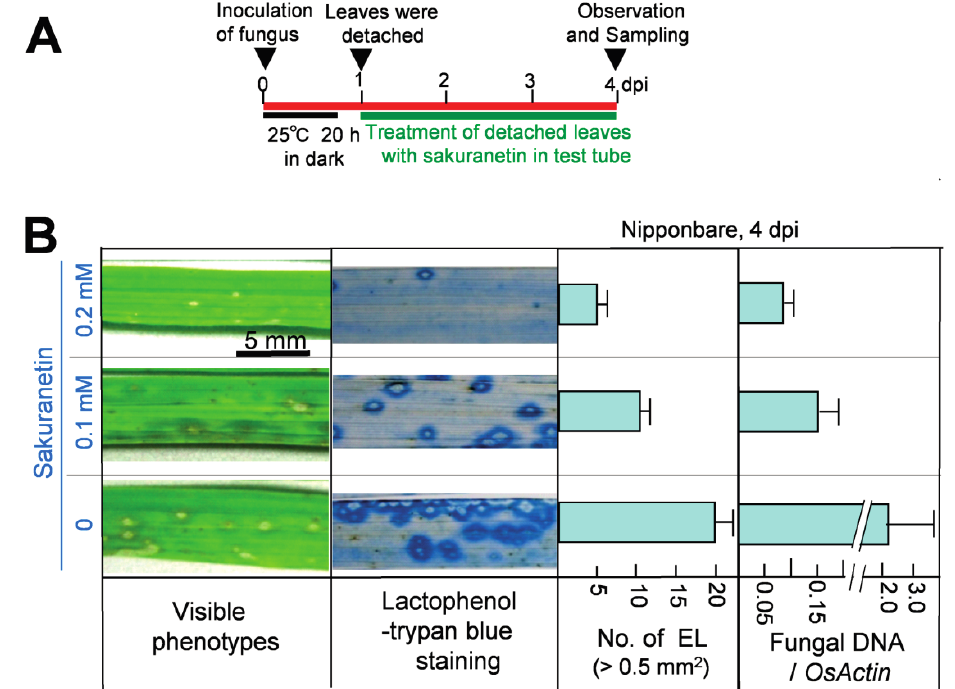
Figure 3. Inhibition of blast fungus growth by sakuranetin in rice leaves at 4 dpi. ( A ) Experimental protocol; ( B ) Leftmost column: visible lesion phenotype on blast-inoculated Nipponbare leaves treated with sakuranetin; second column: phenotype after staining mycelium in inoculated leaves with lactophenol-trypan blue; third column: number of ELs larger than 0.5 mm 2 in a leaf. Rightmost column: fungal DNA content/transcript of OsActin . Data are means ± SE from ten independent samples for ELs and three samples for fungal DNA,